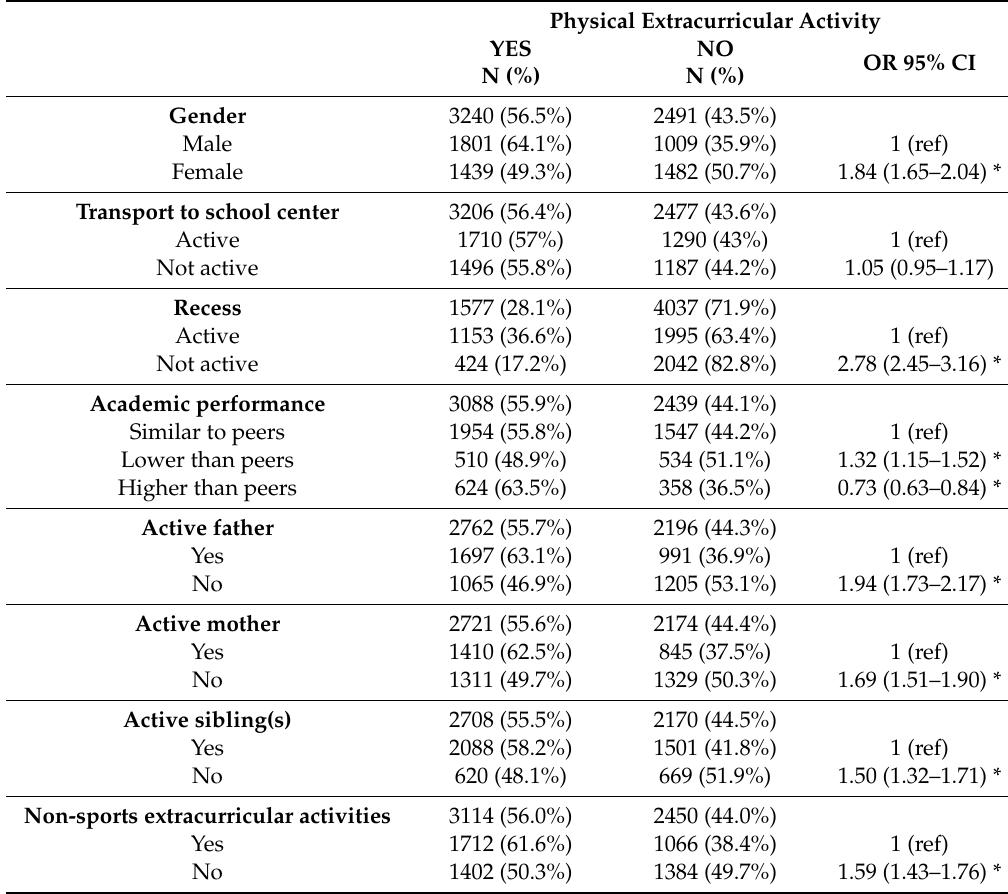
Table 3. Relationship between the variables examined and the extracurricular physical activity in secondary education (from 12 to 16 years